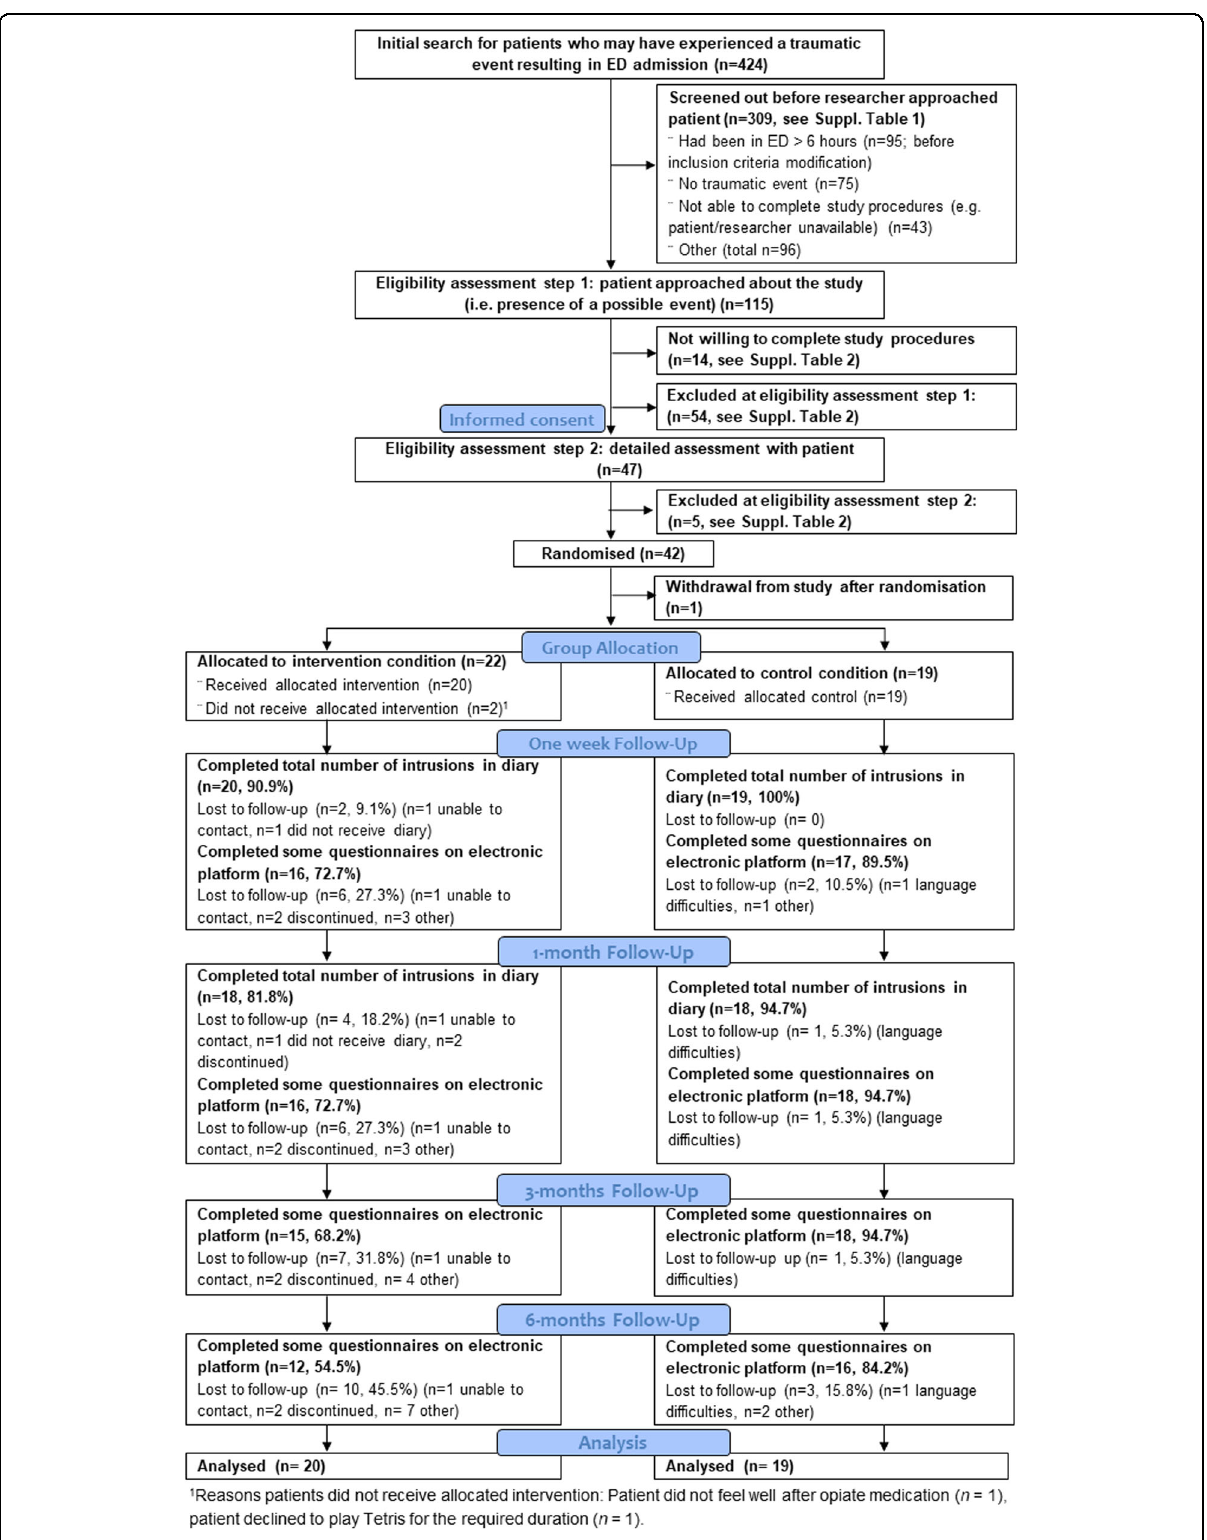
Fig. 1 Participant fl ow through the study. CONSORT